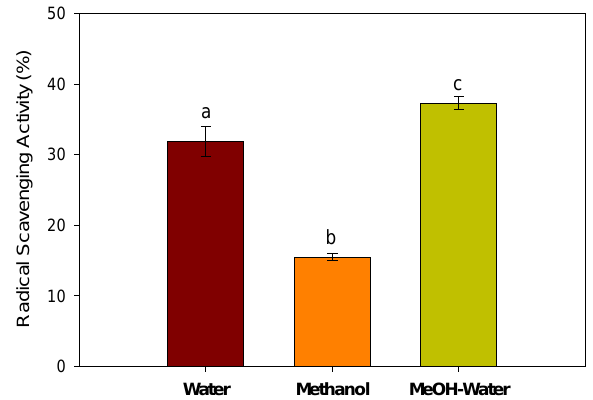
Figure 4. Radical scavenging activity (RSA) of the different extracts of melon seeds. Values are the mean of triplicate readings. Different letters (a–c) represent significant at p < 0.01 (Holm–Sidak method).